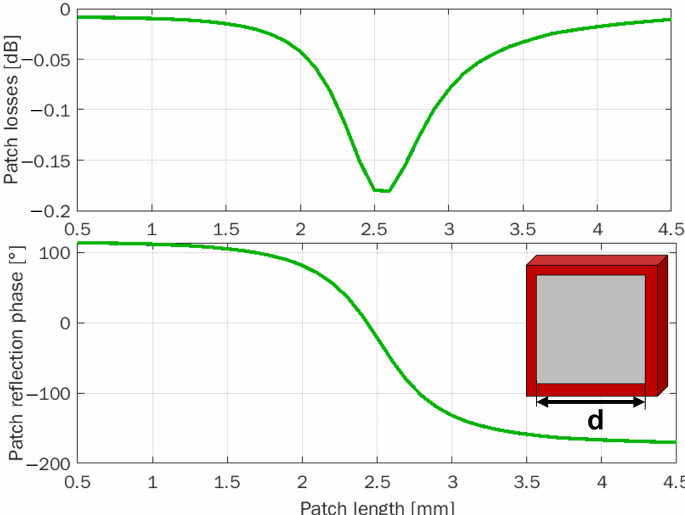
Figure 2. Reflection characteristics of the selected patch: the upper diagram shows the reflection amplitude as function of the patch size, while the bottom part shows the angle variation induced by the reflection.